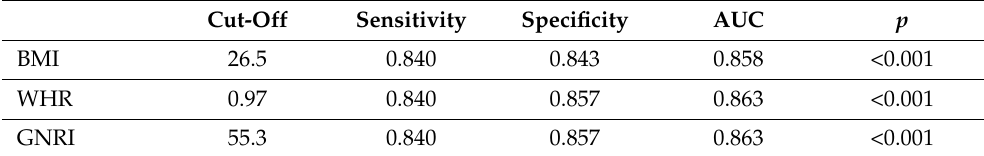
Table 4. Results of ROC analysis of the leading nutritional indices.